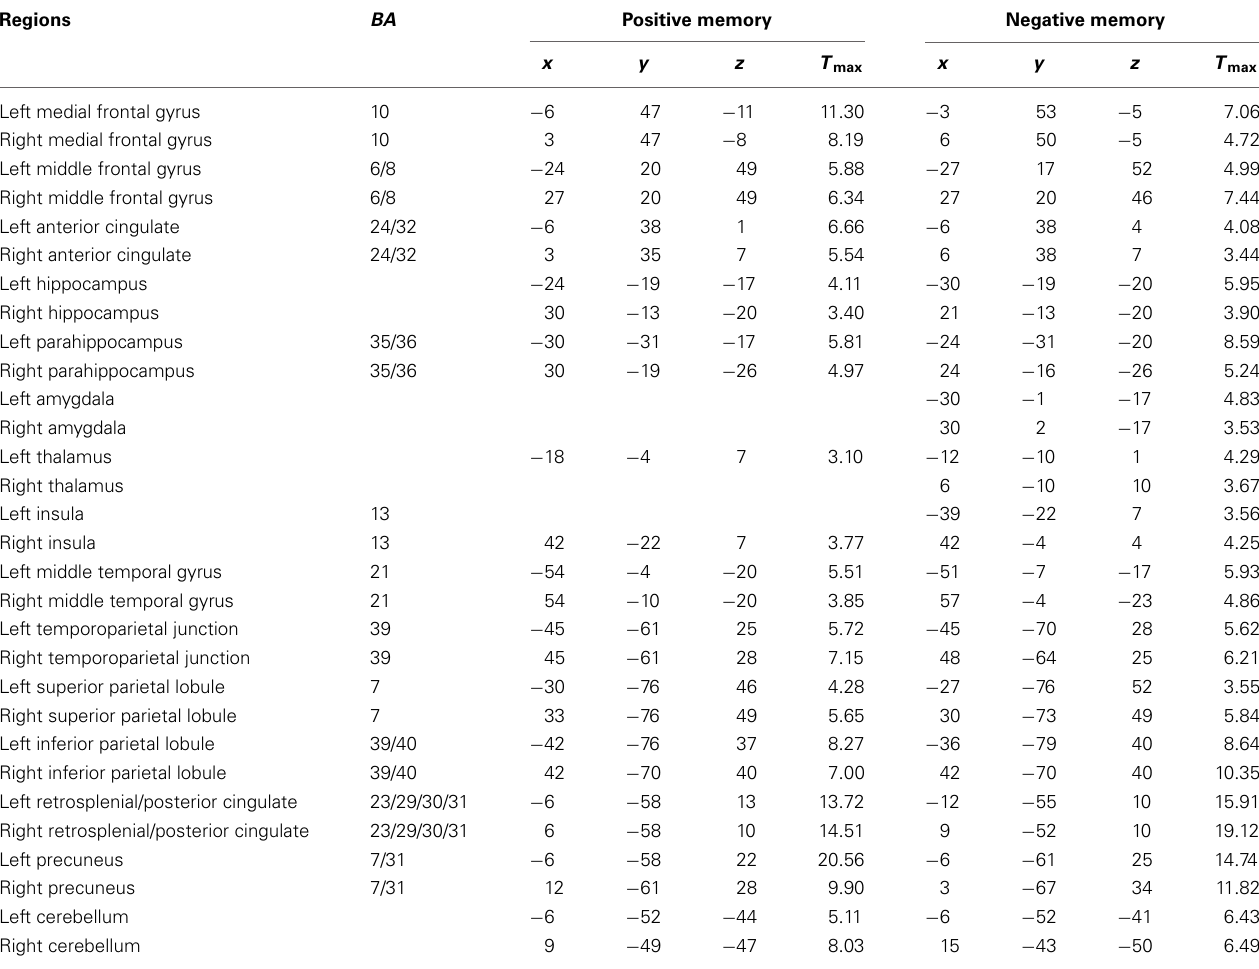
Table 2 | Activated brain regions of the components associated with the positive and negative autobiographical memory tasks for younger